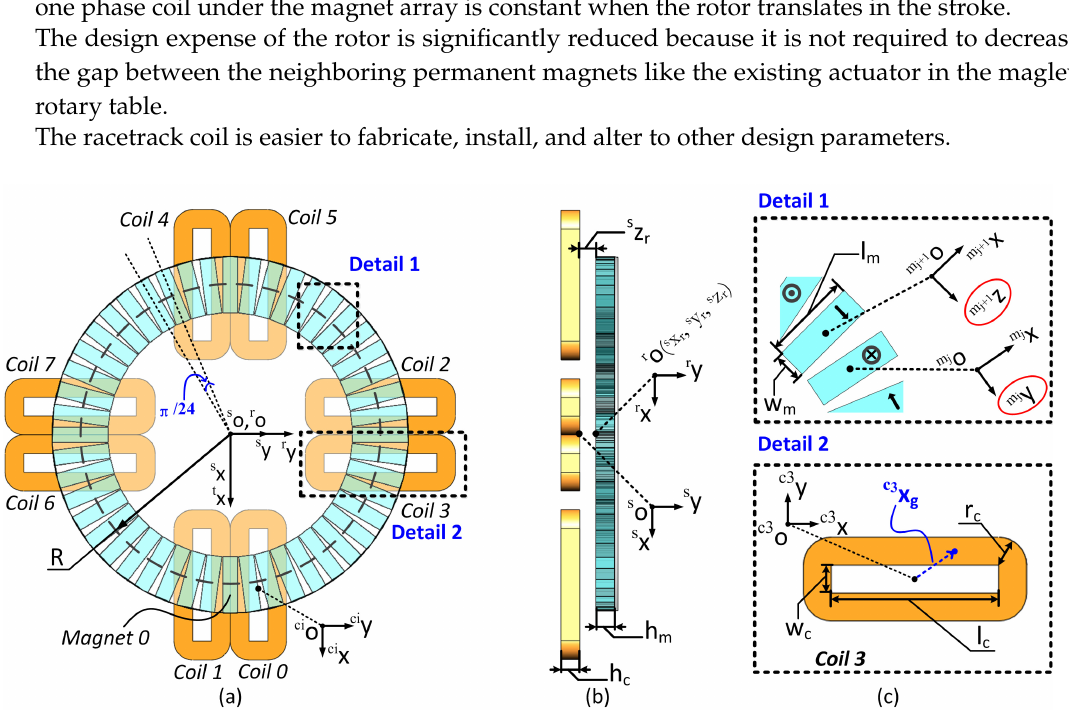
Figure 1. Structure of a magnetically levitated (maglev) actuator for six degrees of freedom (DoF) magnetic levitation rotary table: ( a ) Top view of coil set in stator and magnet array in rotor with corresponding coordinate system, ( b ) side view of coil set and magnet array, ( c ) partial view of one coil and two permanent magnets with a coil coordinate system and magnet coordinate